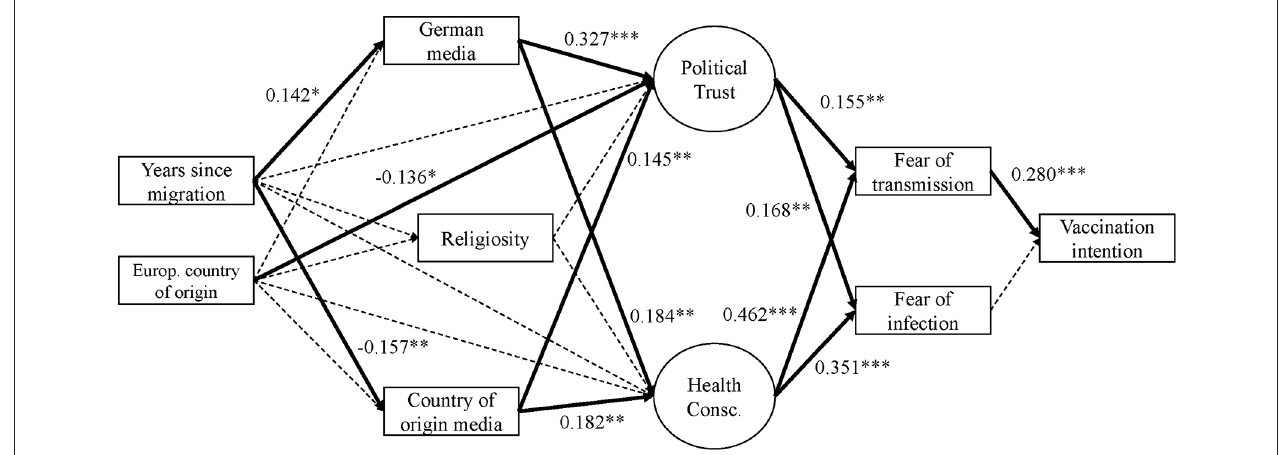
FIGURE 4 | Empirical model 2—migrants only